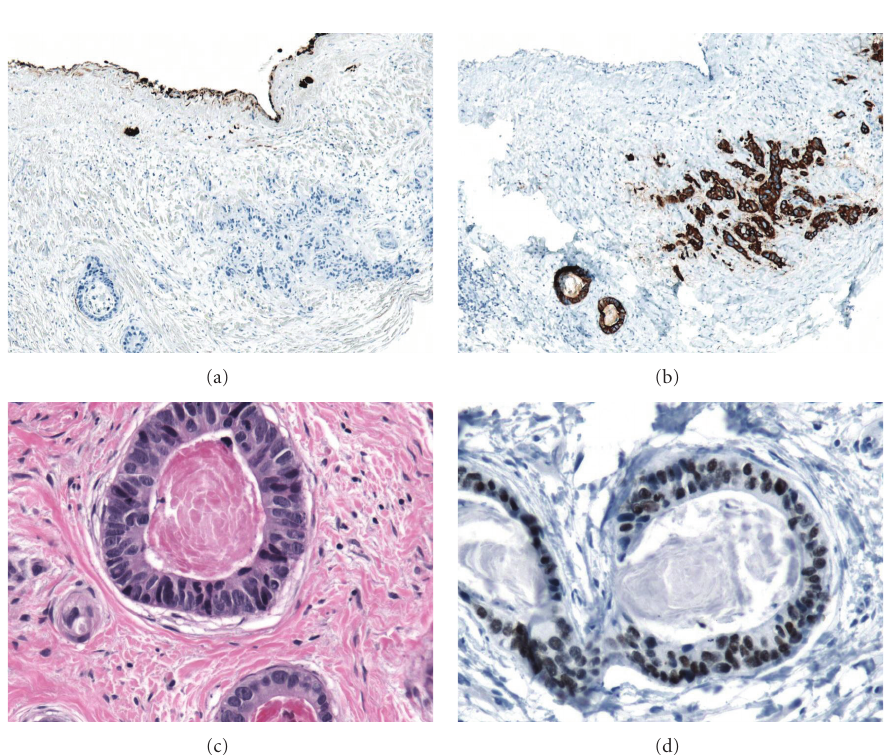
Figure 2: Four pictures from a pleural biopsy showing metastatic adenocarcinoma. (a) Cytokeratin 7 antibody: malignant epithelial structures are negative while benign mesothelial lining is positive (magnification 100x). (b) Cytokeratin 20 antibody: malignant epithelial structures are positive while benign mesothelial lining is negative. Malignancy shows well (left) and poor (right) di ff erentiation (magnifica- tion 100x). (c) picture of the well (glandular) di ff erentiation. Malignant epithelial cells are columnar (H&E staining, magnification 400x). (d) CDX-2 antibody: moderate to strong nuclear staining (magnification